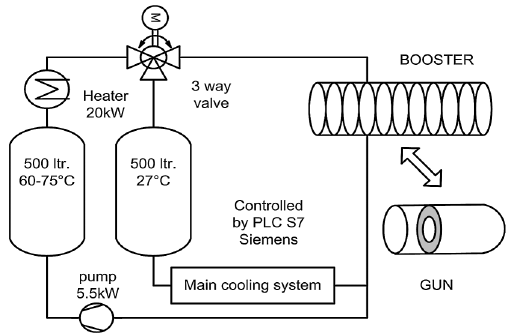
FIG. 9. Schematic diagram of the gun and booster cooling system (water flow is